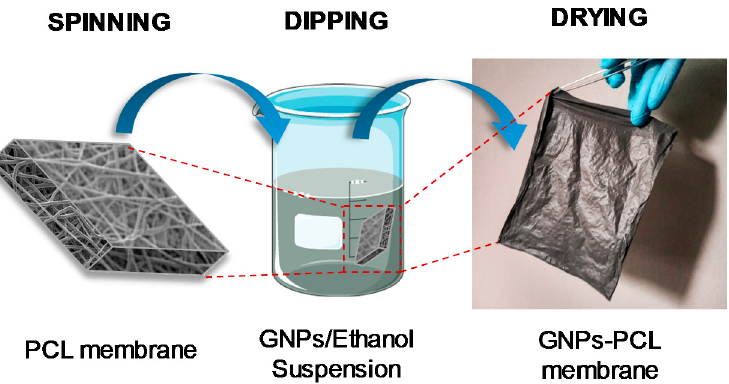
Figure 5. Schematic illustration of the dipping method for GNPs-PCL membranes preparation. The PCL membranes were immersed in an GNPs/Ethanol solution at room temperature for 1 h. Finally, the coated membranes were dried at room temperature.